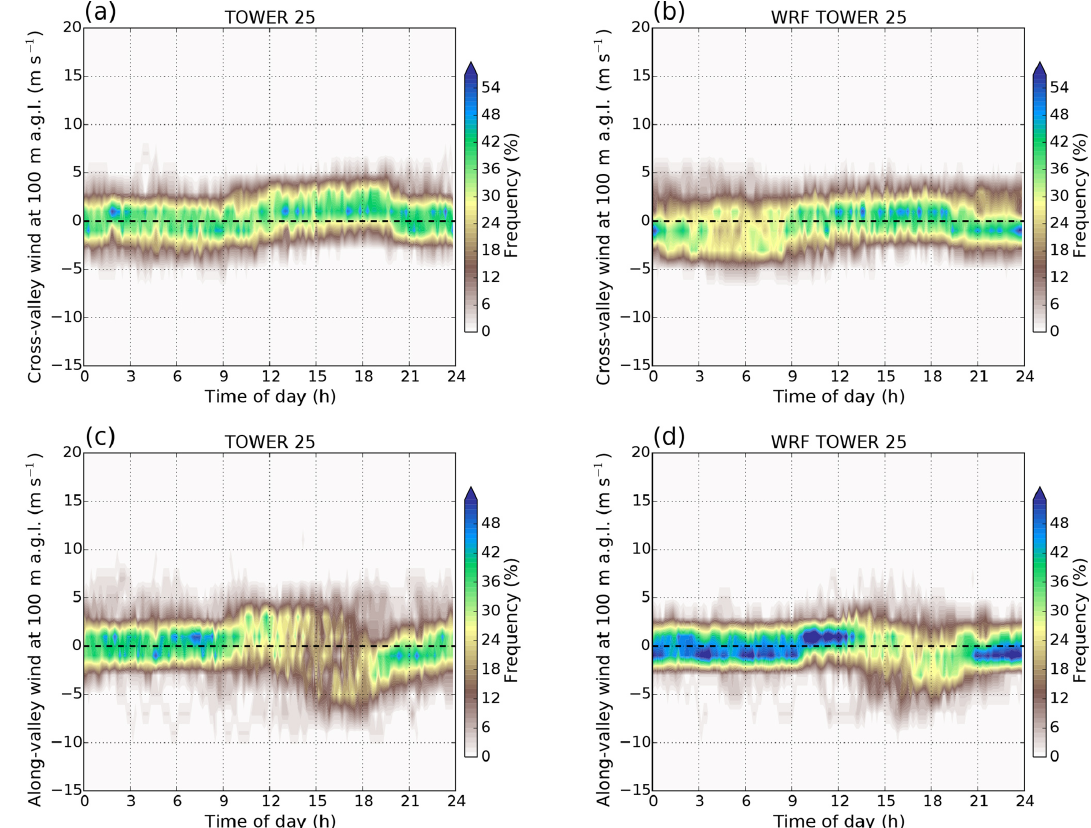
Figure 9. As in Fig. 8 but for tower T25 at the valley